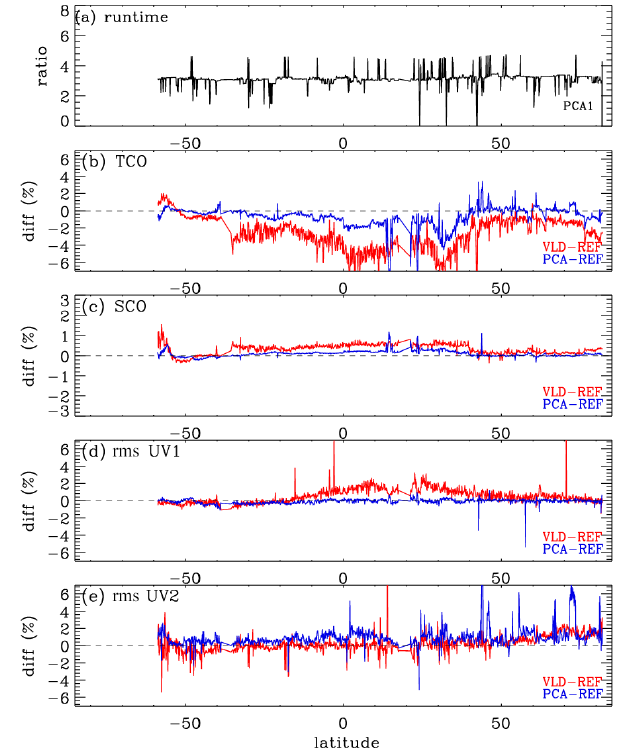
Figure 11. Same as Fig. 10 but for (a) runtime, (b) tropospheric column ozone (TCO), (c) stratospheric column ozone (SCO), and (d) UV1 (270–310nm) and (e) UV2 (310–330nm) fitting residuals, as a function of latitude at nadir cross-track. Note that the fitting residuals are estimated as root mean square (rms) errors for differ- ences between measured and simulated spectra relative to the mea- surement